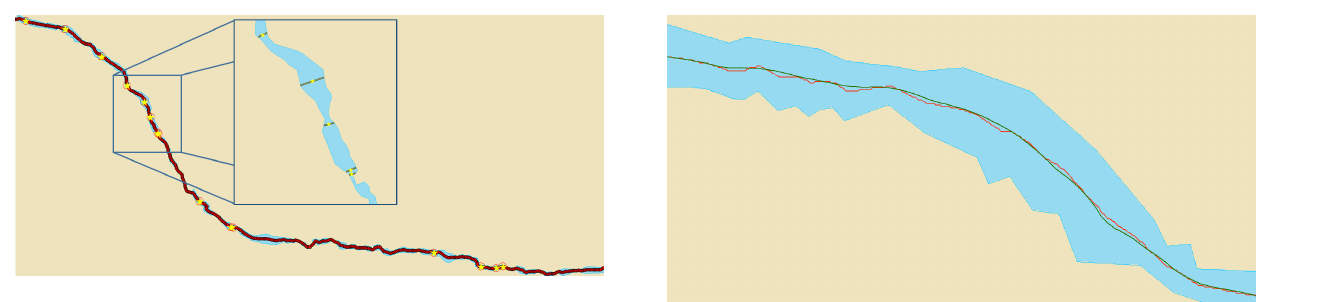
Figure 10. Fifteen random locations (yellow stars) of the 1506 cen- terline points (red dots) at which we evaluated the width manually in a GIS (example in the inset) that are compared to the width of the automated products.